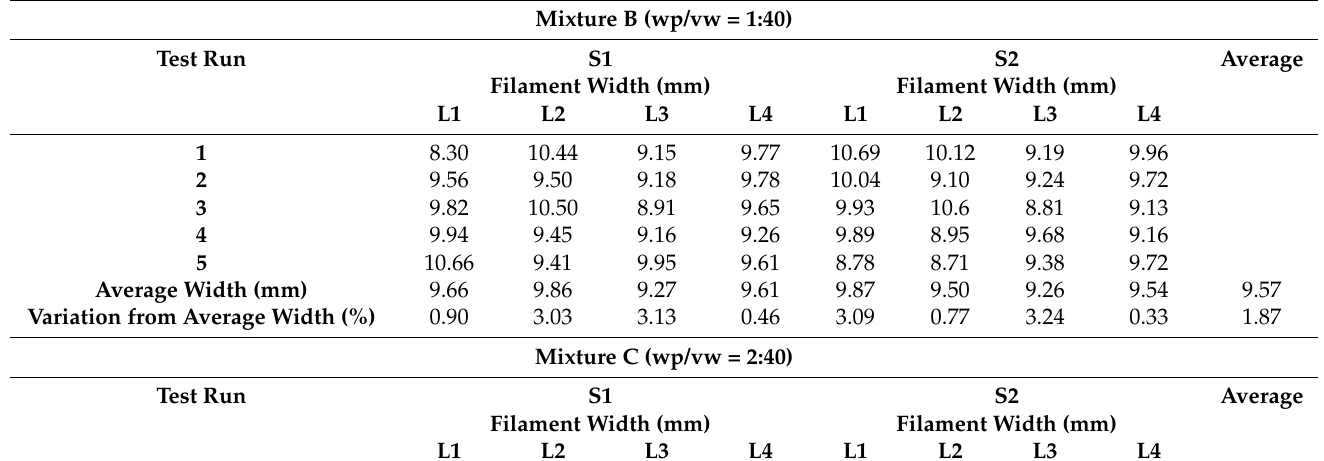
Table 2. Filament width data for samples S1 and S2 printed using Mixtures B and C.